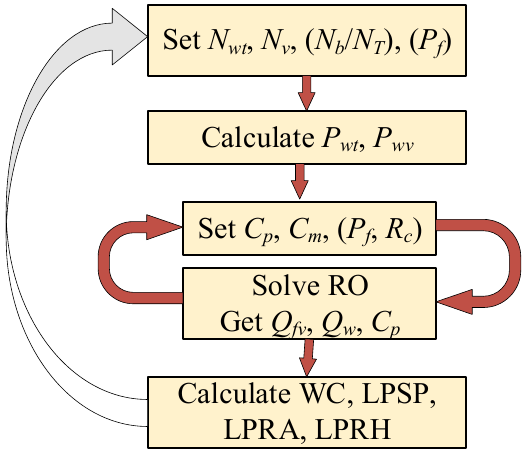
Figure 4. Overall design procedure organigram.